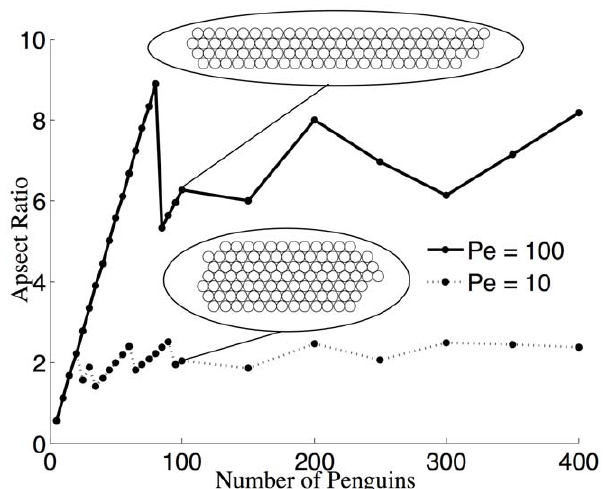
Figure 4. Dependence of the huddle shape on the number of penguins. Aspect ratios of huddles as a function of the number of penguins forming the huddle for fixed Pe´clet numbers, Pe ~ 10 (dotted line) and Pe ~ 100 (solid line) in the deterministic model.